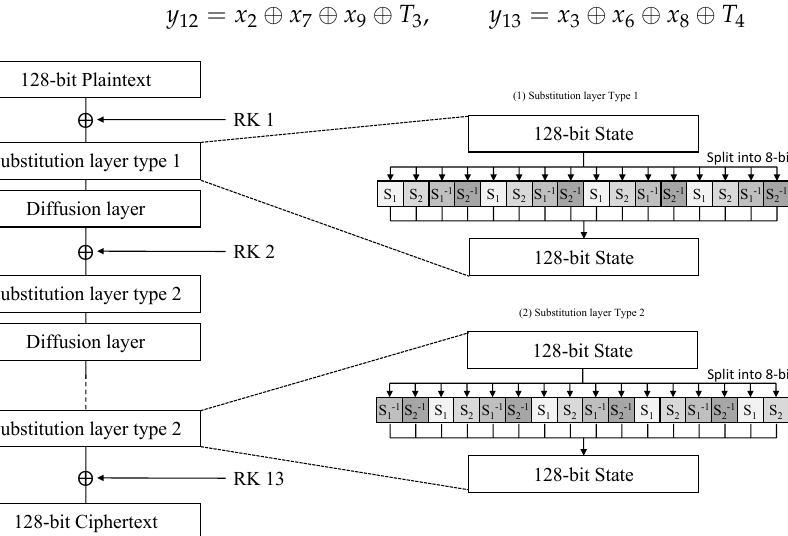
Figure 1. ARIA block cipher algorithm and two types of substitution layers.